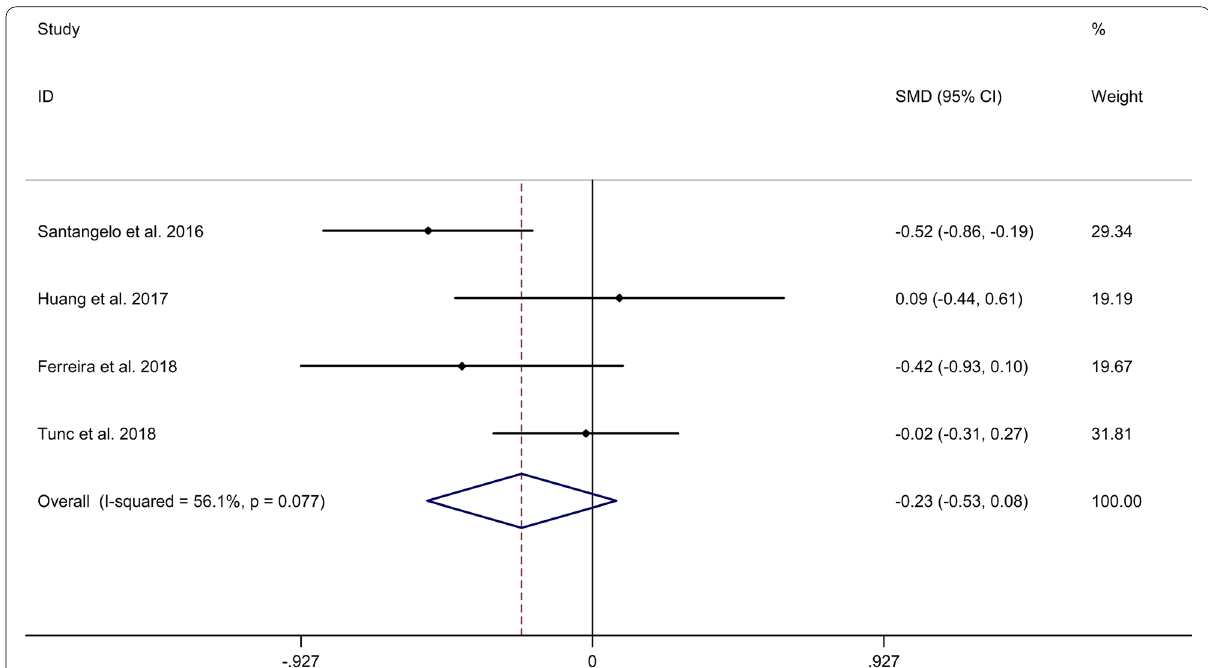
Fig. 3 Forest plots regarding comparison in visuospatial function between migraine group and no migraine group. Abbreviations: CI, confidence interval; SMD, standard mean